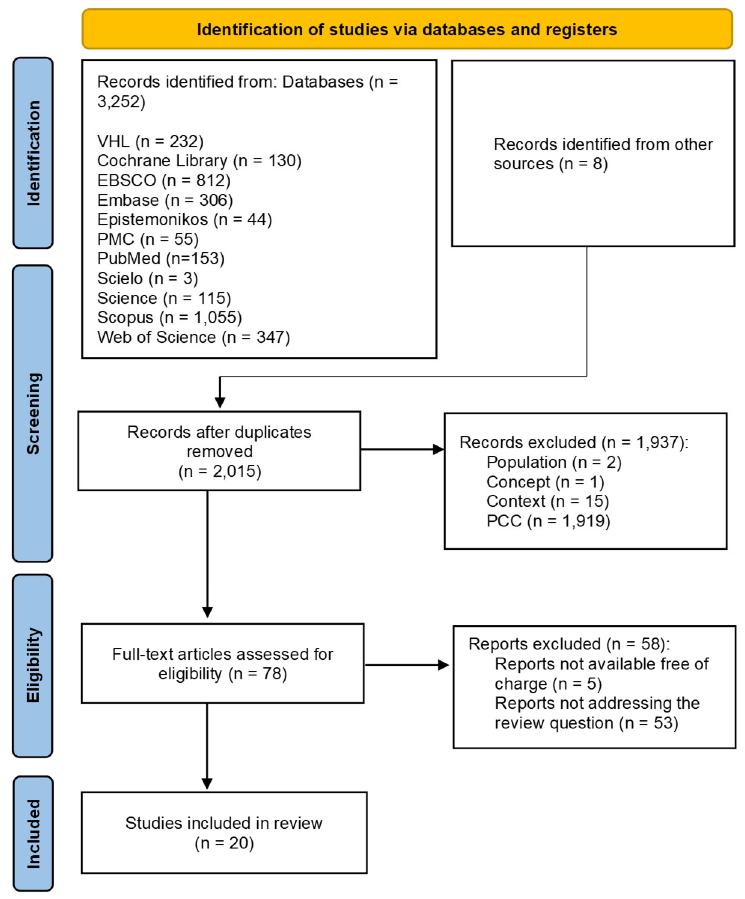
Figure 1. PRISMA ‐ ScR flow diagram. Figure 1. PRISMA-ScR flow